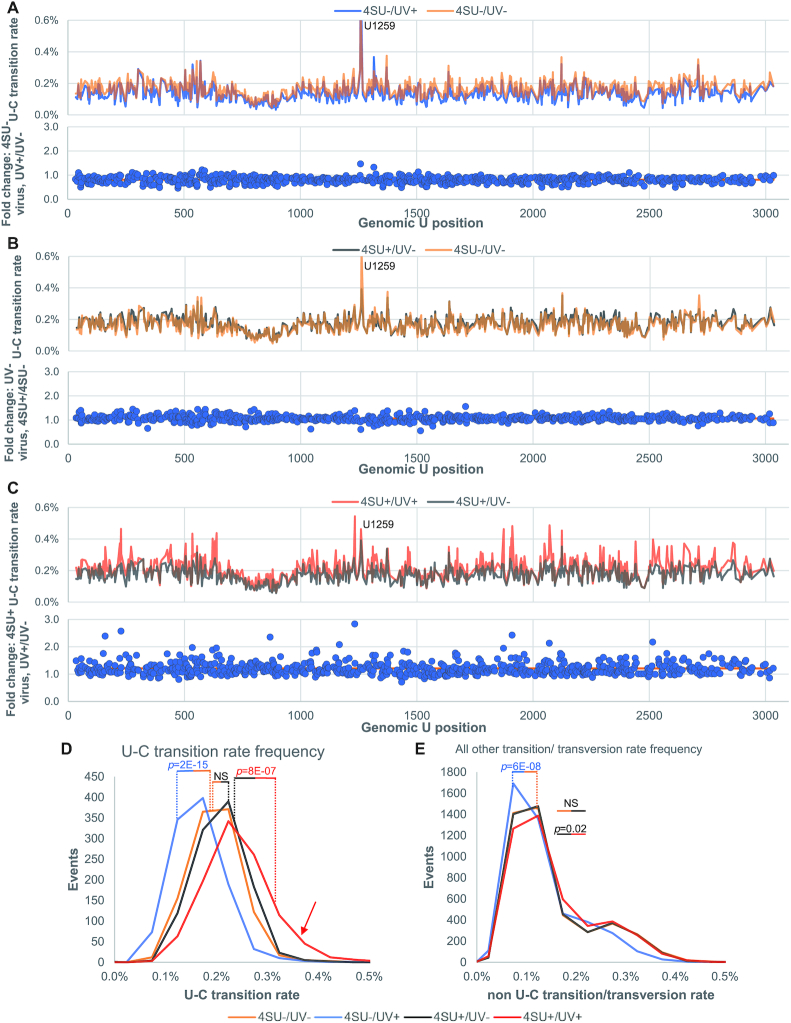
U-C transition rate elevation is specific to 4SU-induced crosslinking. Using FHV RNA 1 as an example, several control experiments were conducted to ensure specificity of vPAR-CL signals. (A) Effects of UV exposure to wt FHV (4SU-) were compared. We did not observe substantial U–C transition rate elevation. (B) Effects of 4SU incorporation were compared to FHV without UV exposure (UV–). We did not observe substantial U-C transition rate elevation. (C) We observed significantly increased U–C transition rates, only when 4SU-containing FHV was irradiated with UV (4SU+/UV+). (A–C) Upper panels illustrate the absolute U–C transition rate for each condition while the lower panels show the relative fold change between the two respective conditions. The orange line in fold change represents the average fold change in each experiment. A U1259C minority variant resulting in an apparent U–C mutation is indicated. (D) The distribution of U–C transition frequencies: only when both 4SU and UV are present (4SU+/UV+, red line), did we observe a significantly higher U–C transition rate (red arrow). (E) While 4SU-/UV+ resulted in a reduced transition rate, no significant difference was found in other samples (all A,G,C-transitions and transversions, or U–A/U–G transversions). (D and E) Statistical assays were conducted with Two-Sampled Kolmogorov–Smirnov (K–S) test with α = 0.05. NS = not significant.